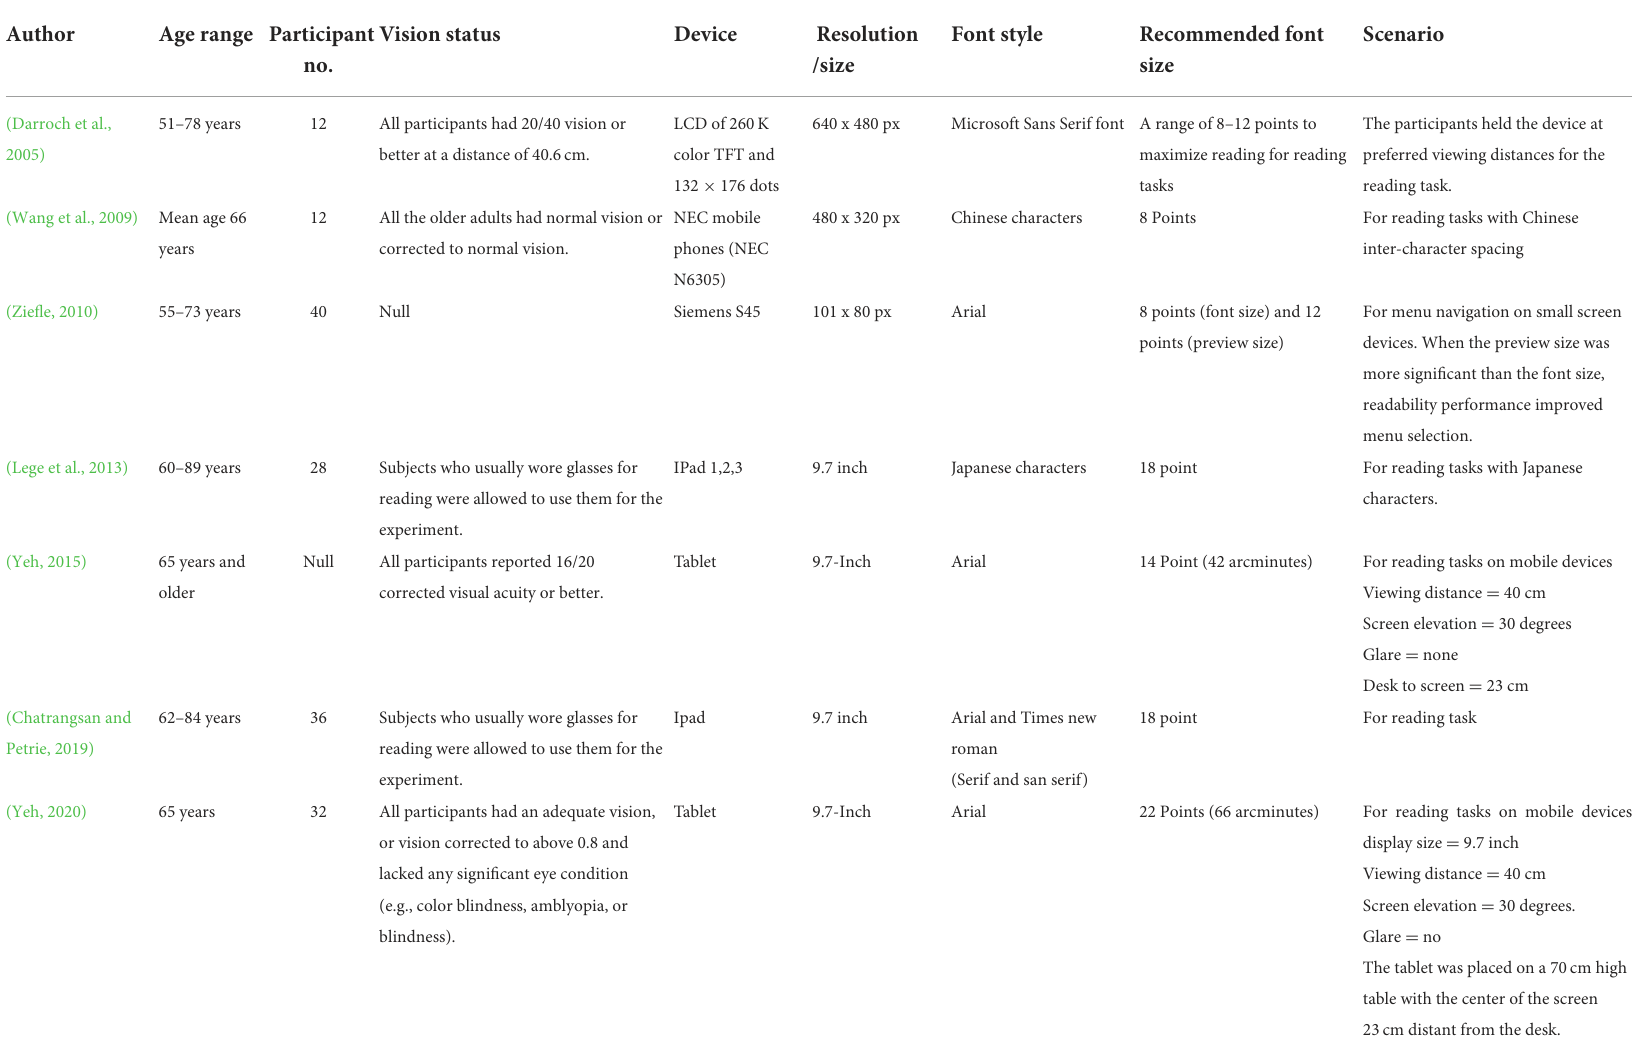
TABLE 7 Font size recommendations from selected paper and